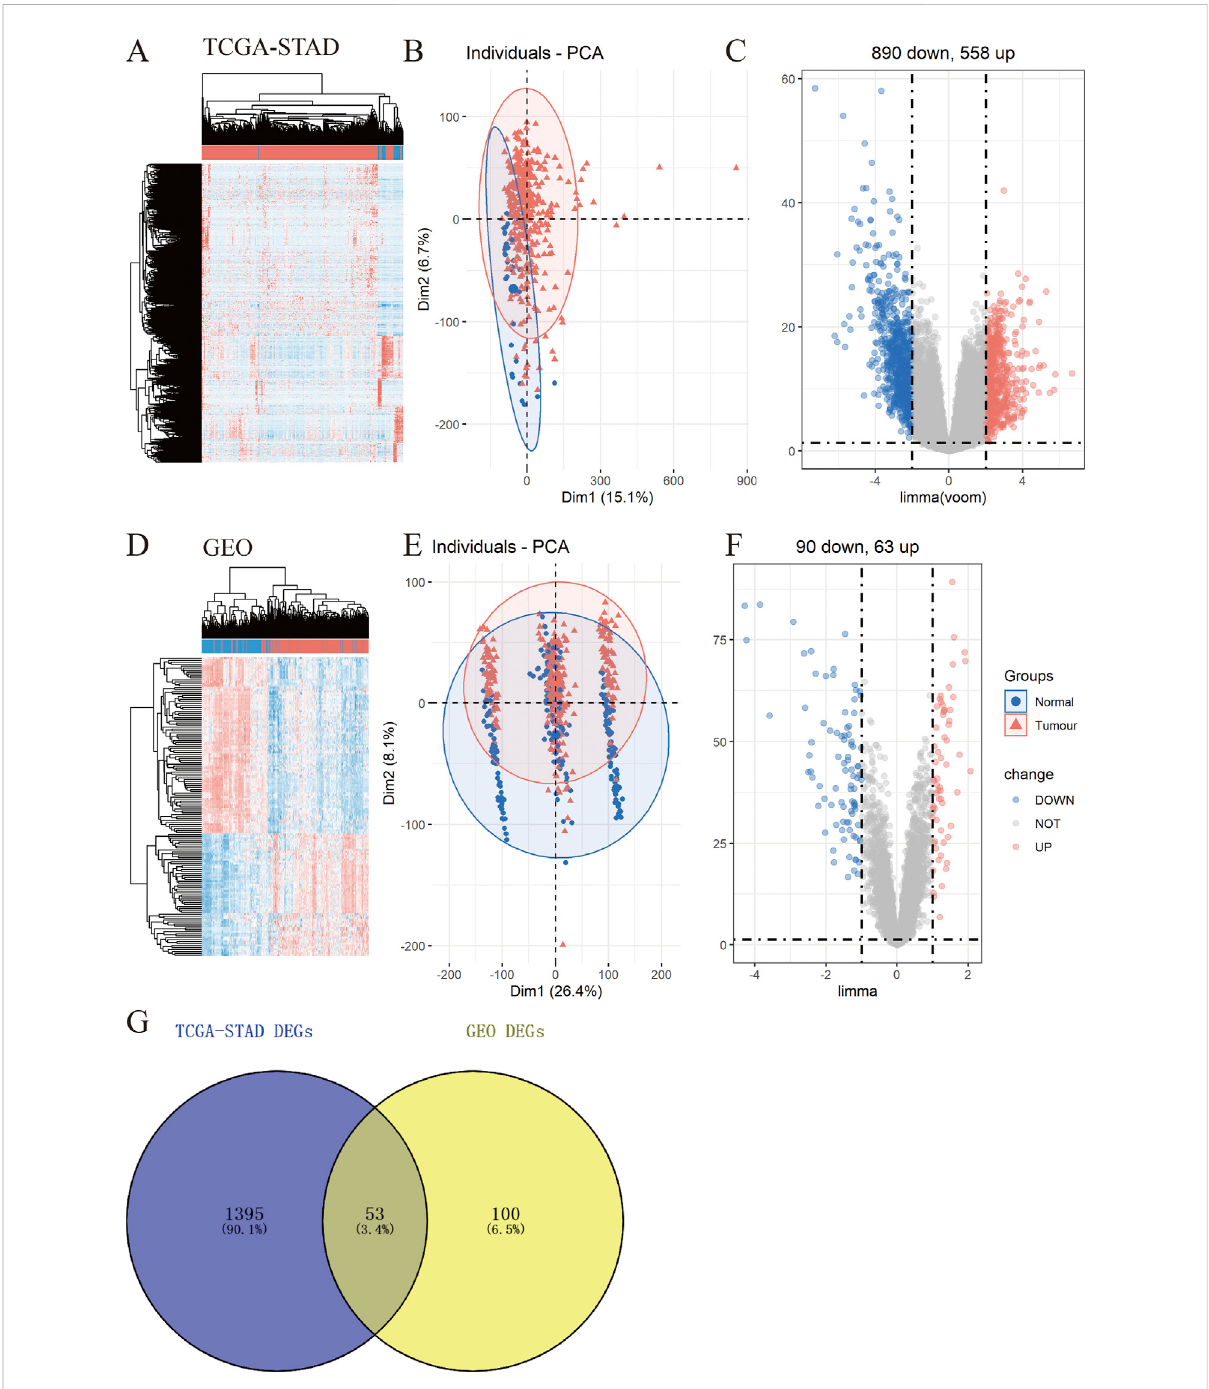
FIGURE 2 Identi fi cation of differentially expressed genes (DEGs) in TCGA-STAD and GEO data cohorts. (A – F) Heatmap, PCA, and Volcano plot of DEGs between normal and tumor samples in TCGA-STAD (A – C) and GEO (D – F) (G) Venn diagram between TCGA-STAD DEGs and GEO DEGs.